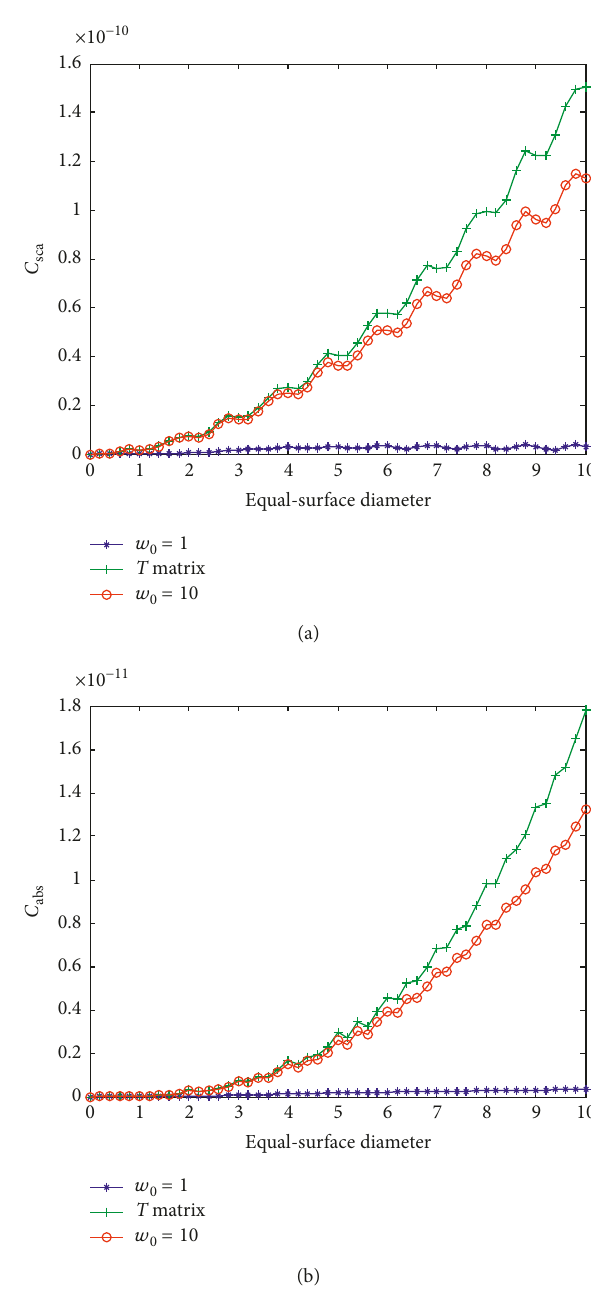
Figure 4: Scattering and absorbing cross sections of feldspar particles ( λ 0.5, m 1.5 +0.001 i ). (cid:31) (cid:31)